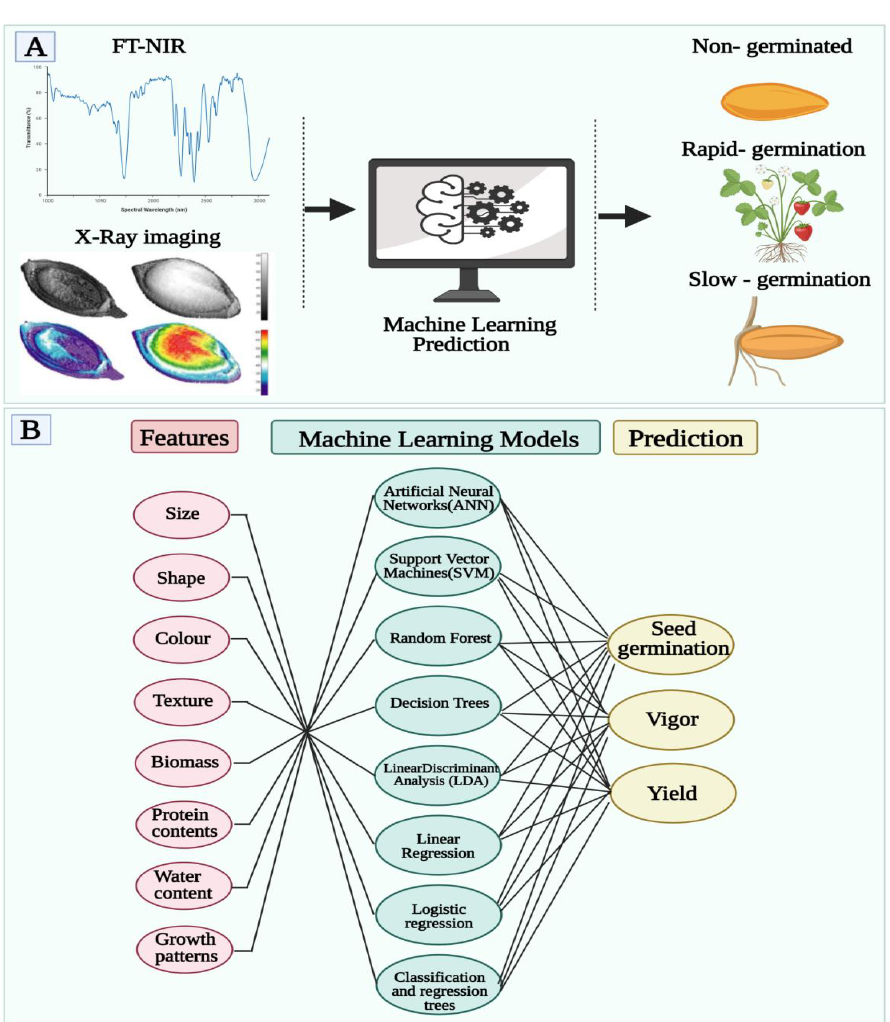
Figure 7. ( A ) Artificial intelligence and machine learning may assist with infrared spectroscopy and X-ray image data mining and curation. AI and ML may further complement via optimizing seed priming technology based on chemianalytic profiling for heat and moisture content assisting in breaking seed dormancy. ( B ) Post nanopriming, AI and ML tools can be used to predict seed germination, vigor, and yield of nanoprimed